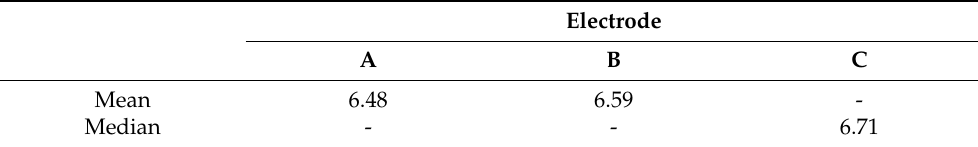
Table 11. Values of the mean and median of the distributions obtained by electrodes A, B, and C.